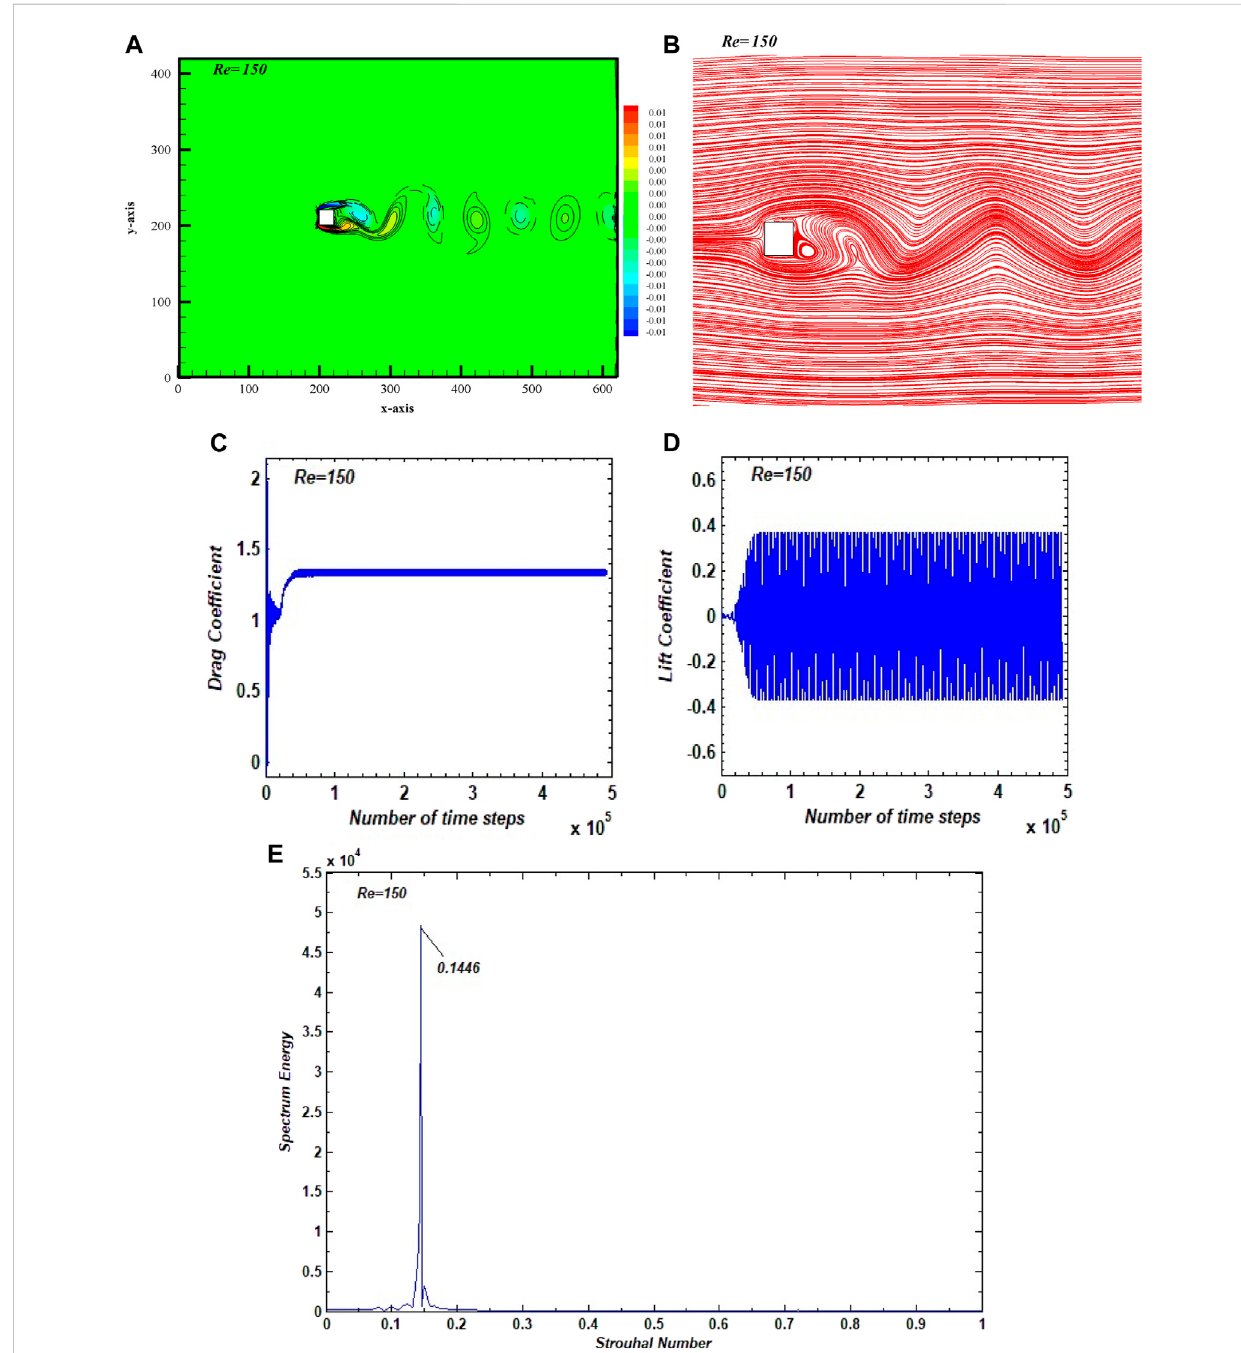
FIGURE 3 (A) Vorticity, (B) streamline, (C) drag coef fi cient, and (D) lift coef fi cient. (E) Power spectrum graphs for the fl ow past a single square cylinder for Re =